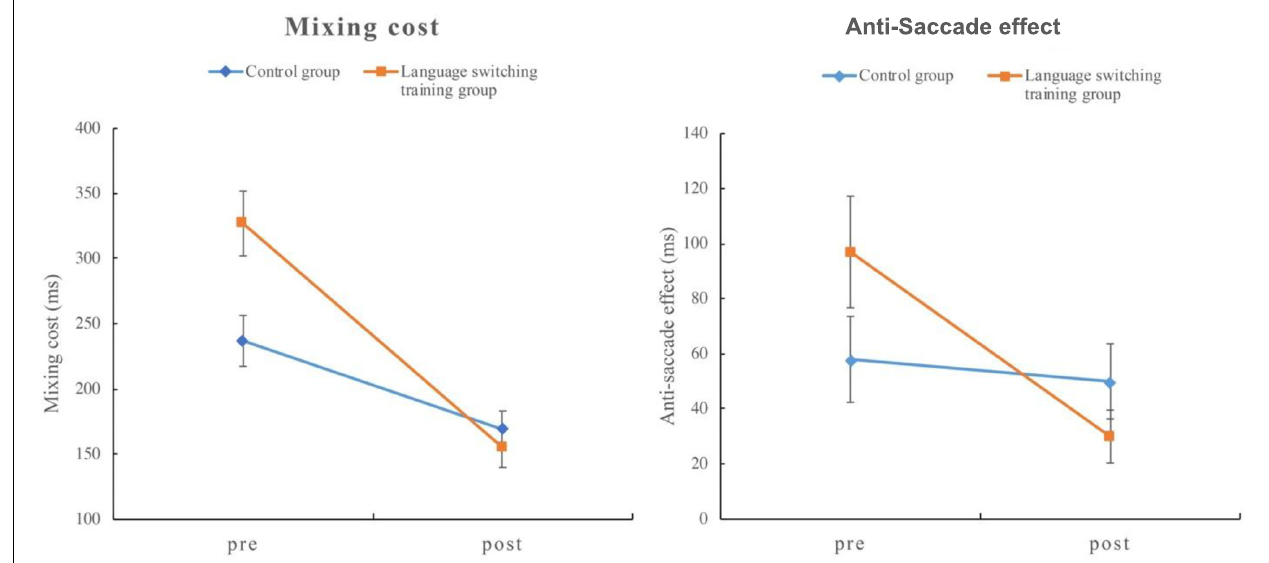
FIGURE 1 | Mixing cost of the color-shape switching task (left) and anti-saccade effect of the anti-saccade task (right) in Experiment 1. Error bar represents standard error.